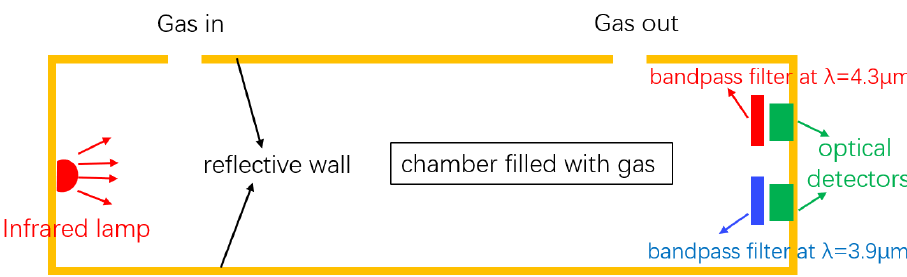
Figure 1. Schematic of a typical NDIR sensor. The sensor consists of an infrared broadband source, a reflecting gas tube, and two optical detectors. The two filters and two detectors form the active channel and reference channel, respectively. Figure adapted from